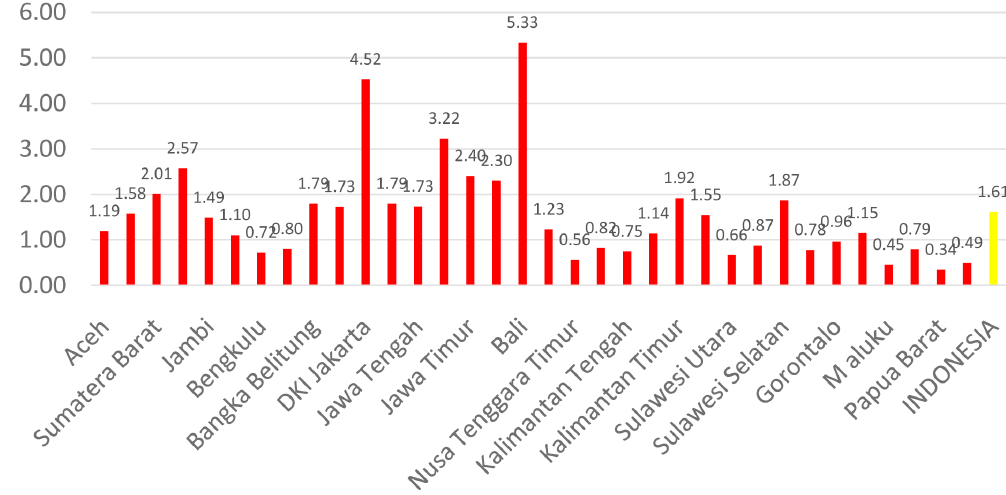
Figure 2. Average number of dentists at every Province in each public health